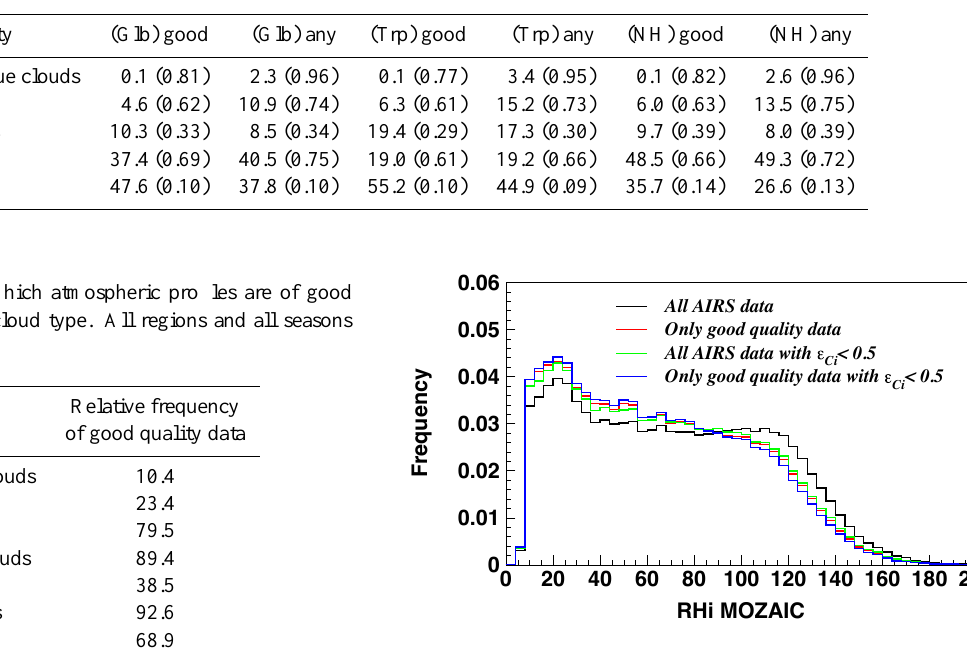
Fig. 1. Distributions of relative humidity seen from MOZAIC RHi M in collocation with AIRS data (all qualities combined) or only with good quality AIRS data for all cloud types and when re- moving the thickest cirrus clouds with (cid:15) cld > 0 .